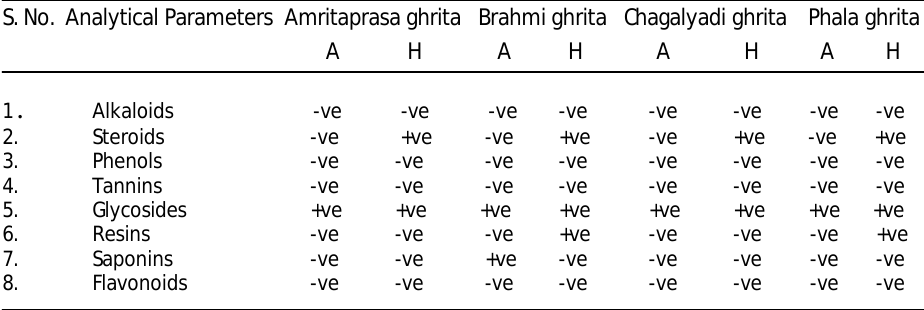
TABLE 2TABLE 2. QUALITATIVE ORGANIC ANALYTICAL DATA OF